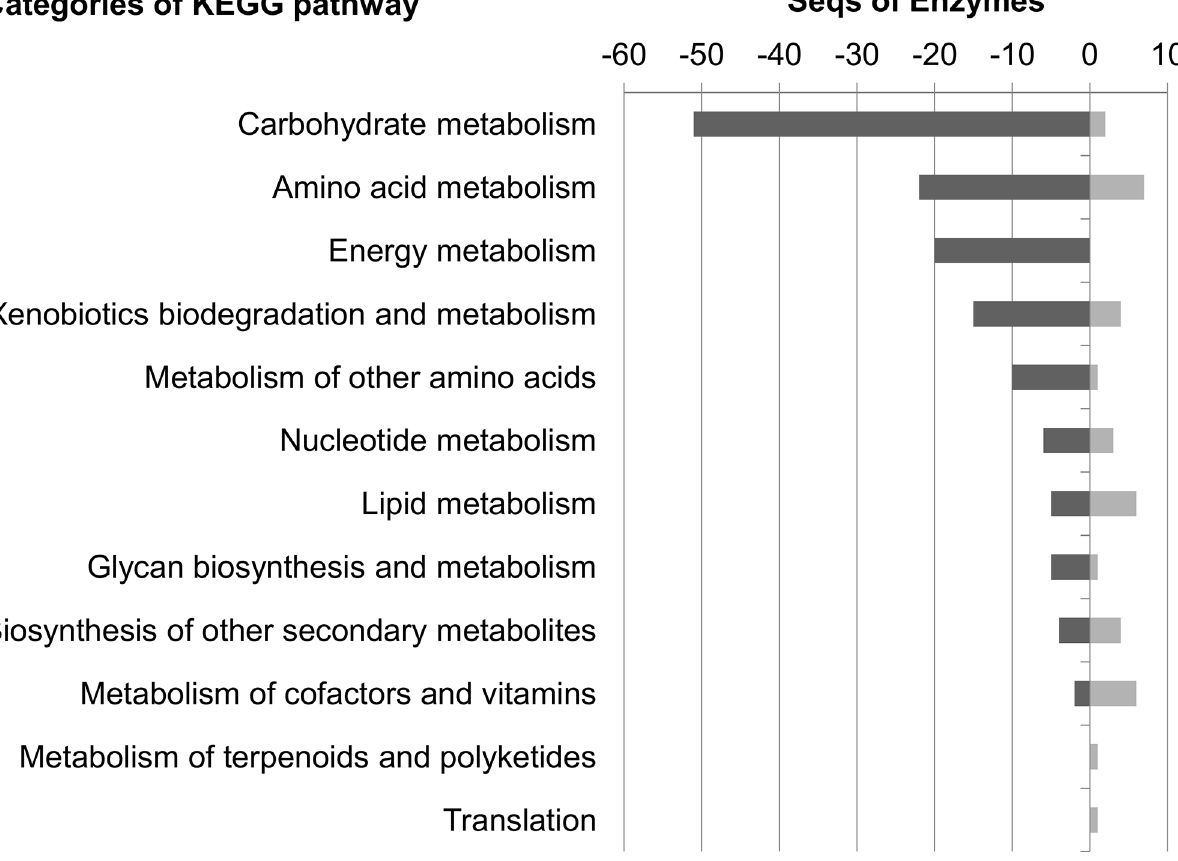
Fig 4. The differentially regulated enzymes were categorised species-independent using the KEGG pathway analyses. Dark grey charts represent the downregulated proteins in the mutant strain, light grey, in contrast, the upregulated ones. The numbers reflect the sequences of enzymes sorted to the different